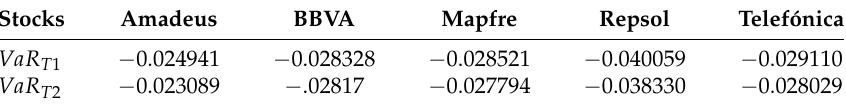
Table 5. Values at risk VaR T 1 [ 0.05; a , b )] and VaR T 2 [ 0.05; a , b , c ] for the five stocks